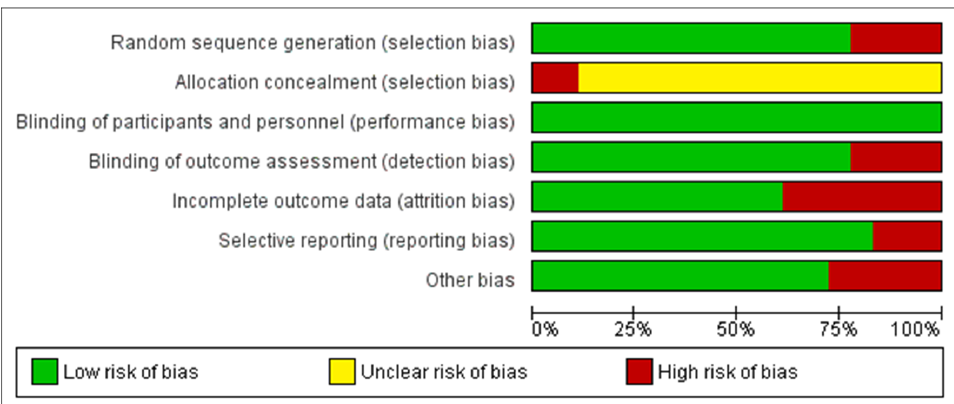
Figure 3. Graph of risk of bias: authors’ judgements about each risk of bias item presented as percentages across all included studies.